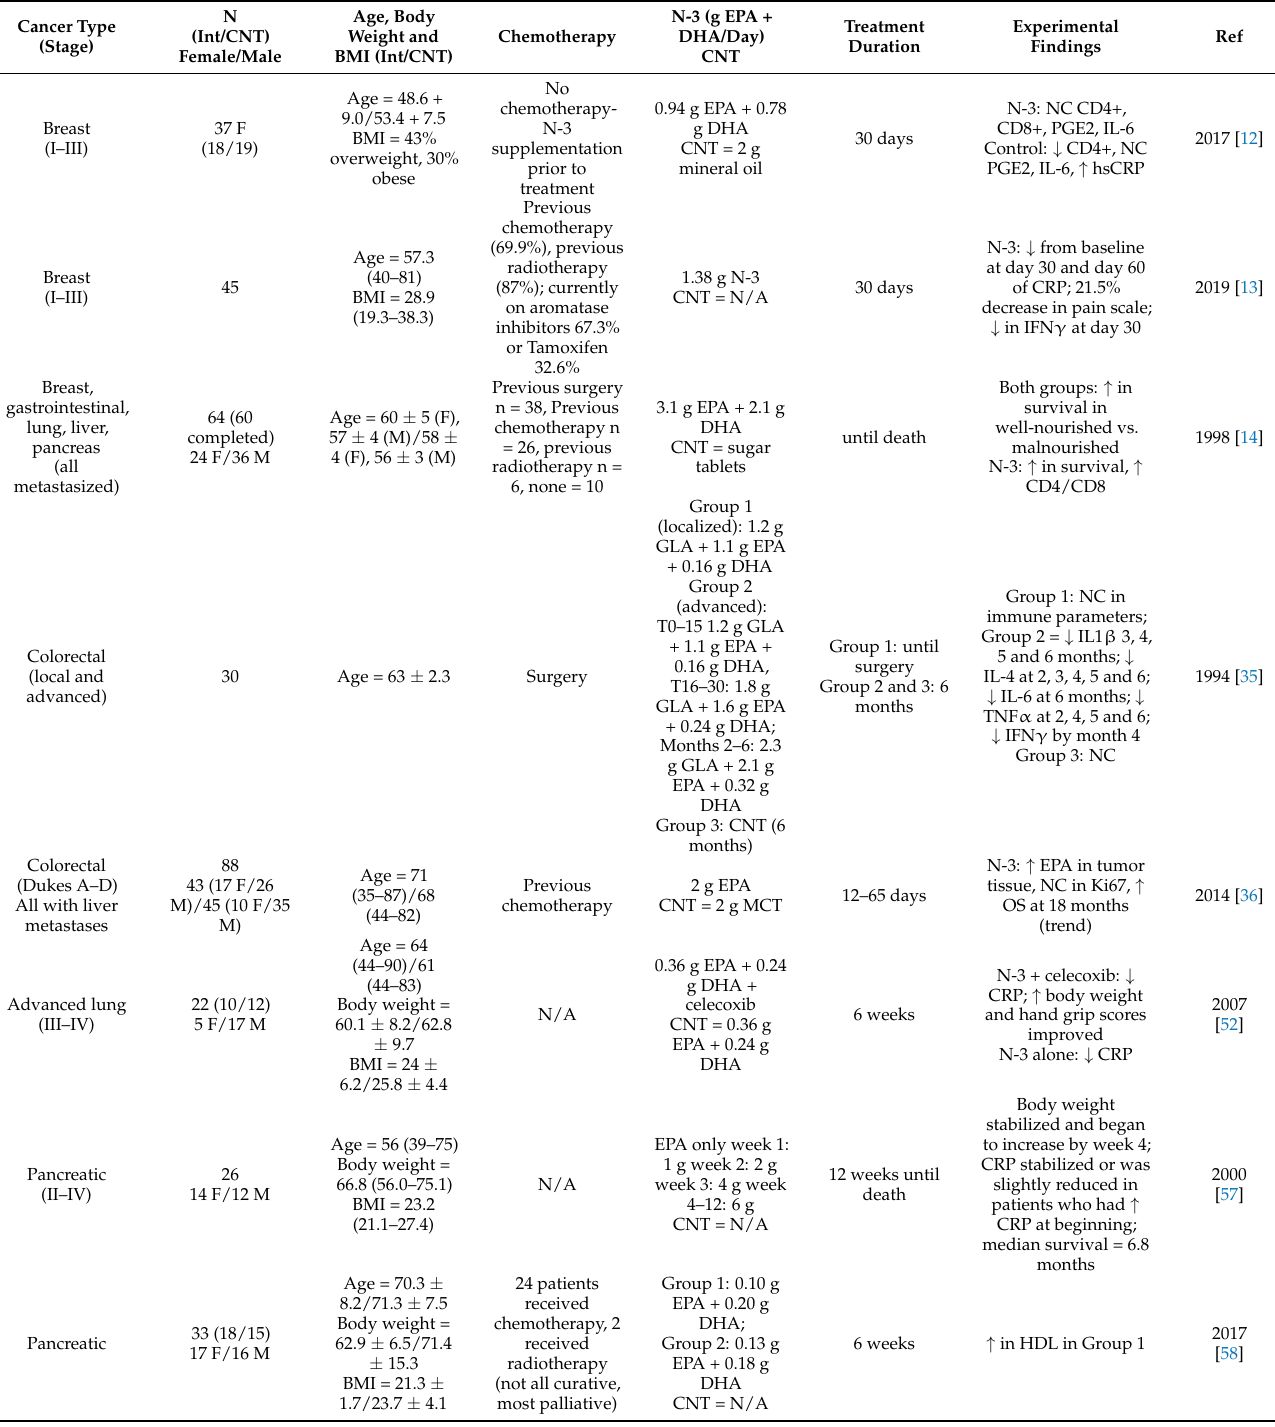
Table 2. Randomized controlled trials providing N-3 supplementation without